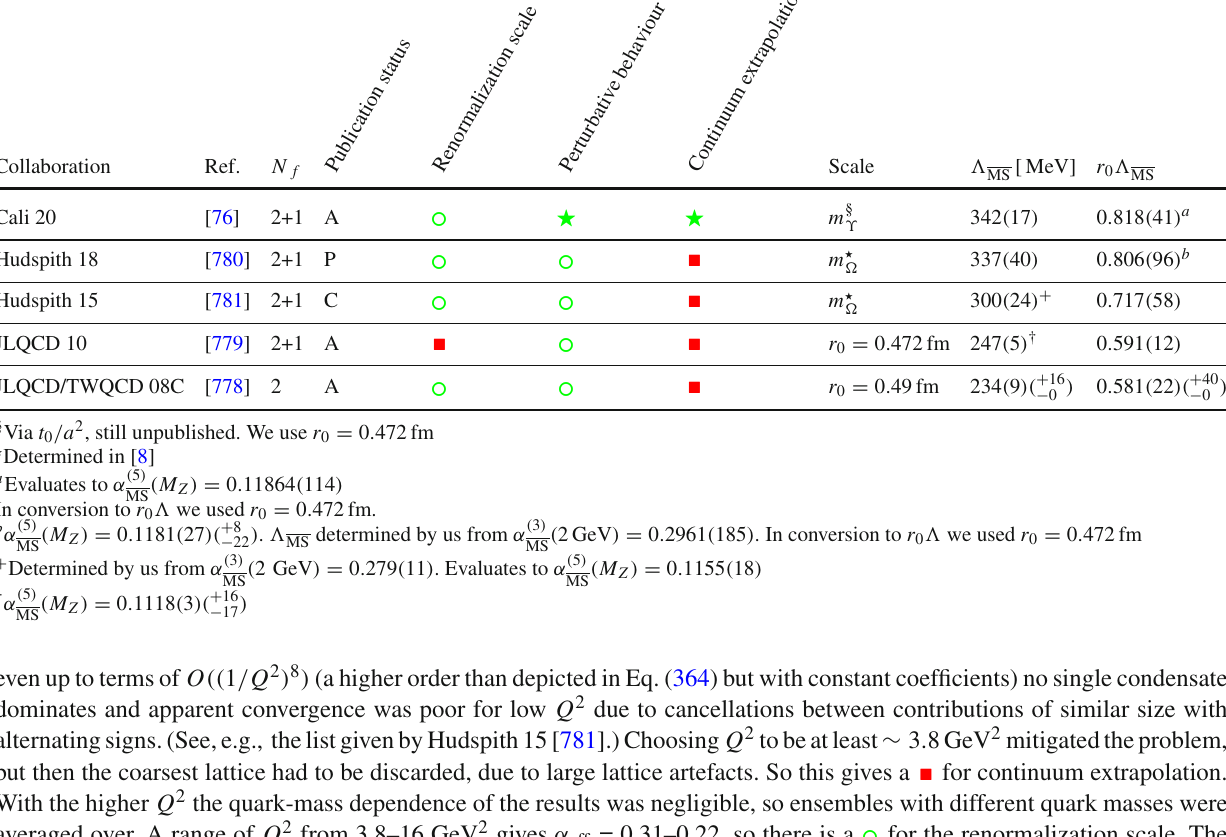
Table 62 Results from the vacuum polarization in both momentum and position space